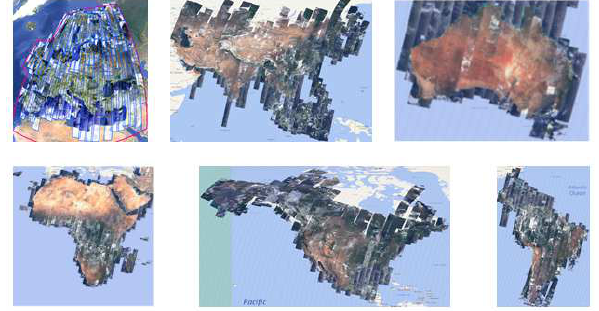
Figure 2. Overview of the Sentinel-2 GRI selection done by IGN, March 2017. European GRI products were selected in the frame of S2A In-Orbit Commissioning Review (IOCR) context, in October 2015, with CNES IQ expertise center (ESA cooperation), whereas other blocks were selected in the frame of S2A routine context with MPC (ESRIN contract).